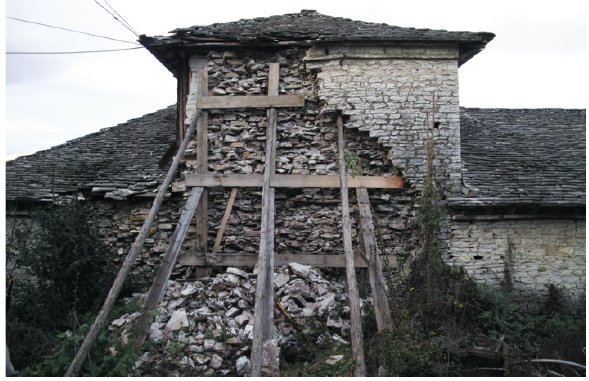
Figure 7. Back of Fico house (© M. Carta).